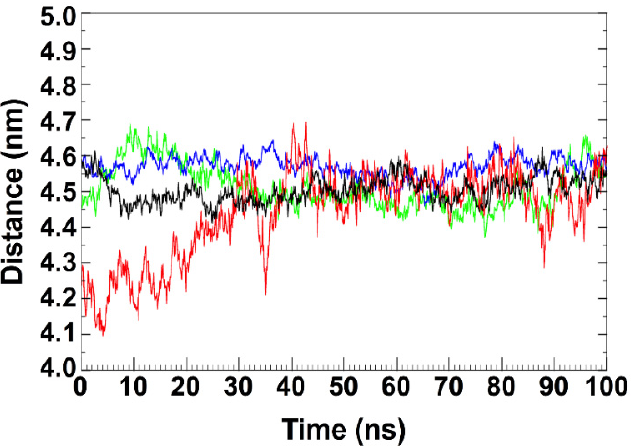
Figure 11. Time-dependent analysis of the distance evaluated between the centers of mass of the bovine lactoferrin and the receptor binding domain in the up conformation of the four Spike variants (black: Alpha, red: Beta, green: Delta and blue: Omicron). Table 3. Results of the MM/GBSA analyses performed over the last 30 ns of the Spike-bovine lactoferrin complex simulation for the four variants of MM/GBSA analyses confirmed the high affinity of the bLf for the Spike glycoprotein (Table 3), showing an interaction energy of − 36.2, − 69.1, − 46.4 and − 45.8 kcal/mol for the